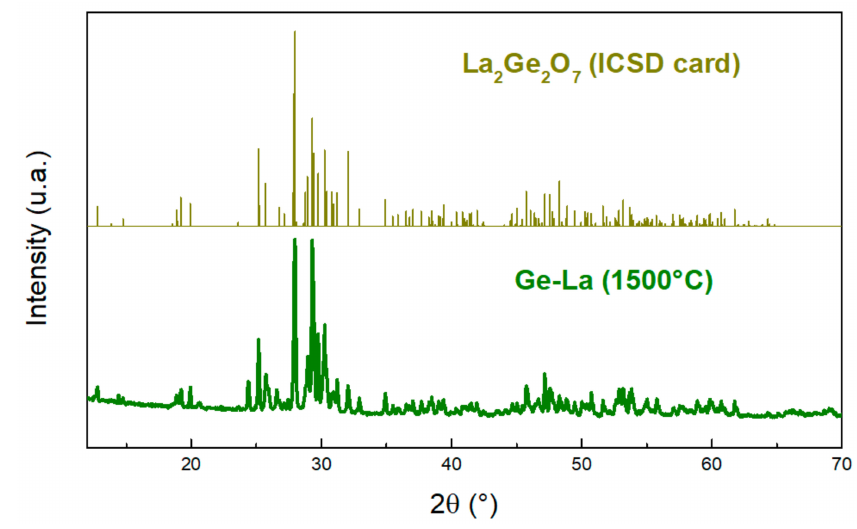
Figure 12. XRD patterns of Ge-La after thermal treatment with the ICSD card of La 2 Ge 2 O 7 [35]. Adapted with permission from Ref. [35]. Copyright 2022, Elsevier.